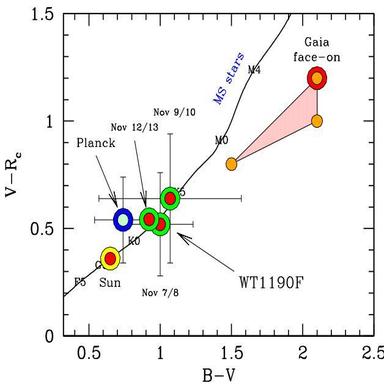
The ðB V Þ versus ðV RcÞ average colors of WT1190F along the three observing runs of 2015 November, from Loiano. The target colors are compared with other reference objects, namely the Planck and Gaia spacecraft, the Sun, and the locus of Main Sequence stars, according to the calibration (solid curve, labeled with the stellar spectral type). WT1190F appears to be slightly ''redder" than the Sun, but very close in color to Planck. It would also quite well match the colors of a star of spectral